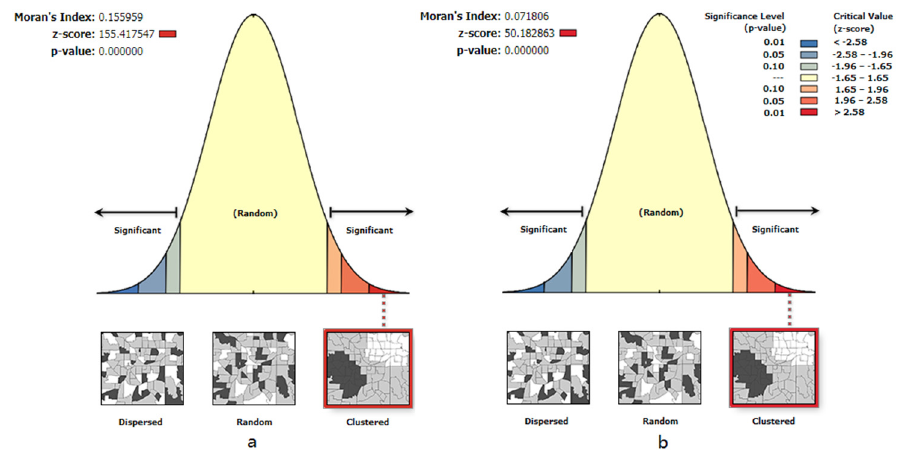
Figure 6. Clustering mode of multifunctional business space. ( a ) shows Moran index of spatial distribution of multifunctional forest management suitability, and ( b ) shows Moran index of spatial distribution of dominant functions in the study area.